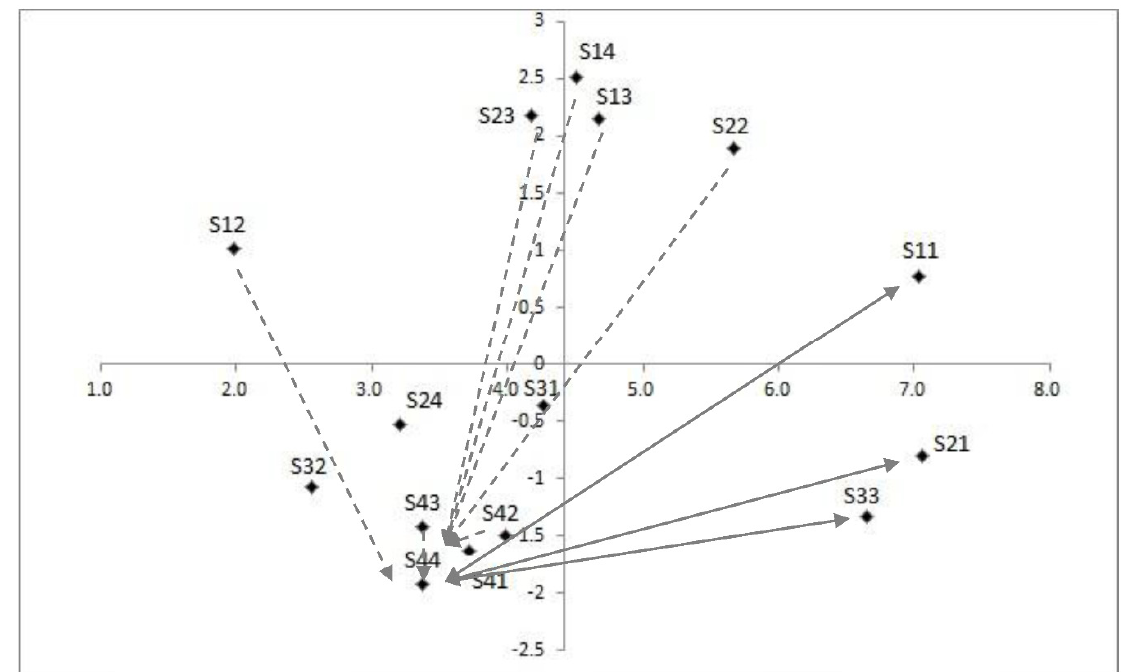
Figure A15. Casual Diagram between S44 and Other